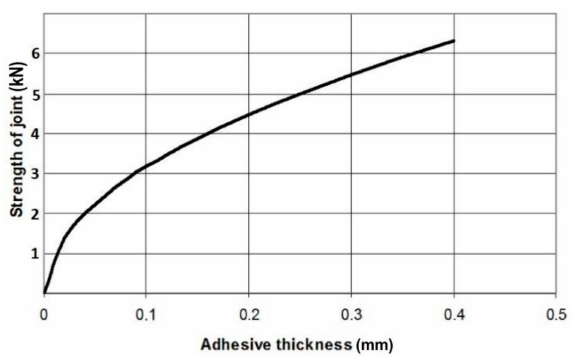
Figure 1. Theoretical dependence of lap adhesive joint strength upon adhesive layer thickness when failure stress of the adhesive layer is not dependent on adhesive layer thickness (vertical axis non-dimensional).